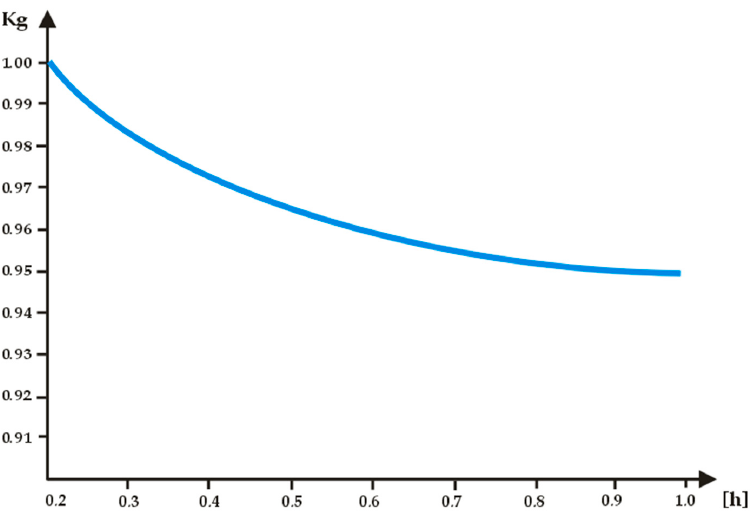
Figure 5. A graph showing how repair time affects the wind farm equipment’s operational